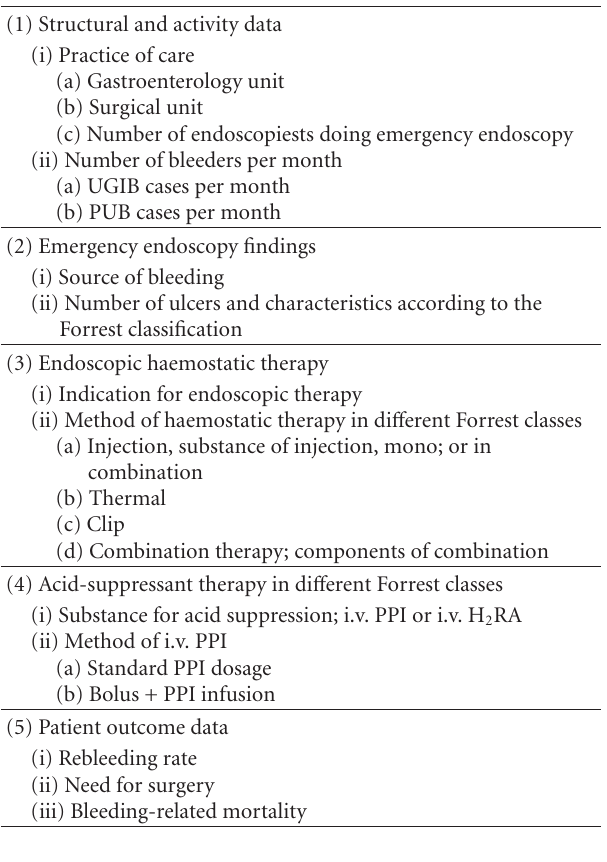
Table 1: Main points of the questionnaire for upper GI bleeders in